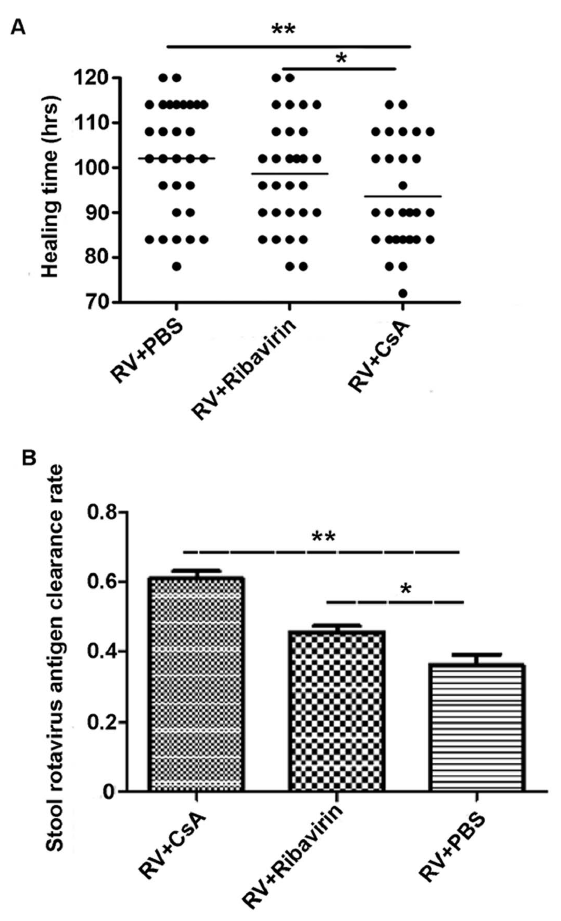
Figure 5. Effect of CsA on SA11 rotavirus-infected neonatal mouse model. Neonatal mice were inoculated with SA11 rotavirus, and mice developed diarrhea during the 18–24 h of experimental observation. The mice scored for diarrhea were randomly divided into 3 groups (30 mice each group). Mice were subjected to PBS, Ribavirin (5 mg/kg/d), or CsA (2.5 mg/kg/d) treatments by oral gavages. (A) Healing time. (B) Rotavirus-antigen clearance rate (%) in stool. Data shown are expressed as mean 6 standard deviation of triplicate cultures, and are representative of 3 experiments (* P , 0.05, ** P , 0.01).